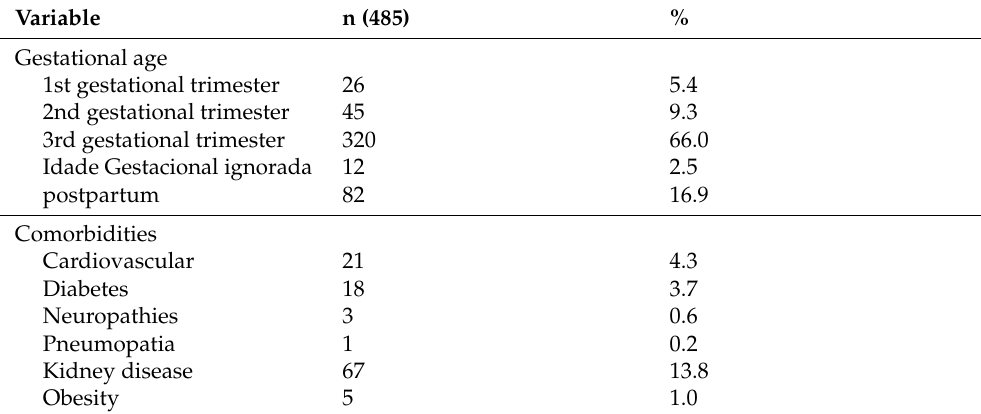
Table 3. Epidemiological profile of COVID-19 cases in pregnant and postpartum women. Cear á . Brazil,